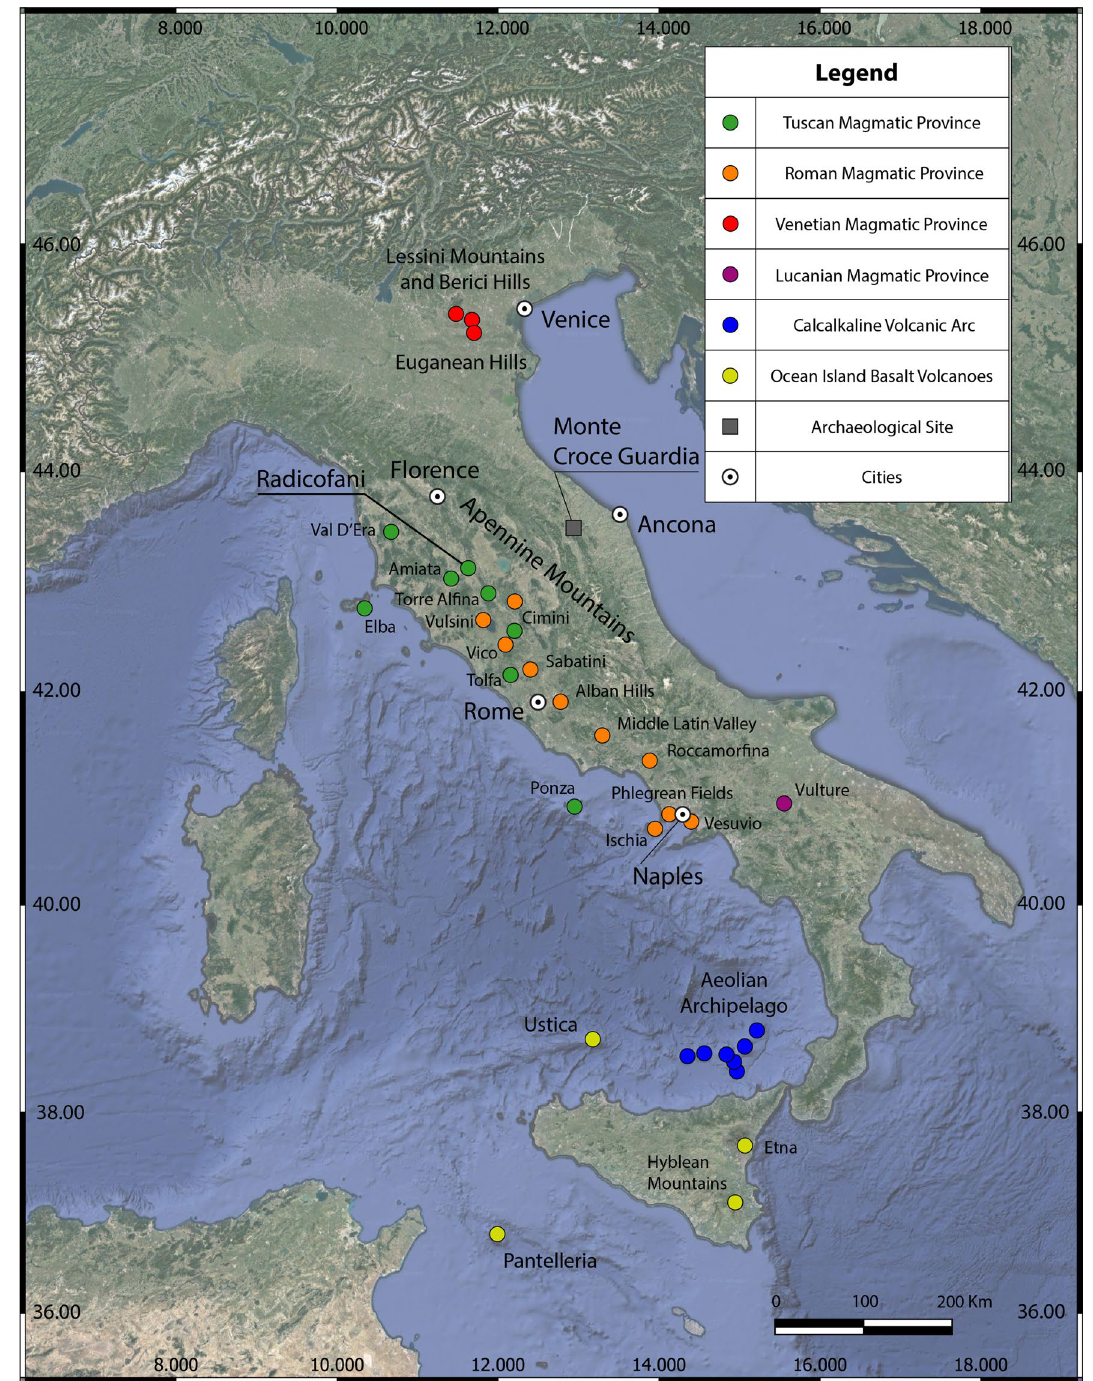
Figure 2. Distribution of the main volcanism in Italy with related magmatic provinces/volcanoes (modified) 3 and the location of the Monte Croce Guardia archaeological